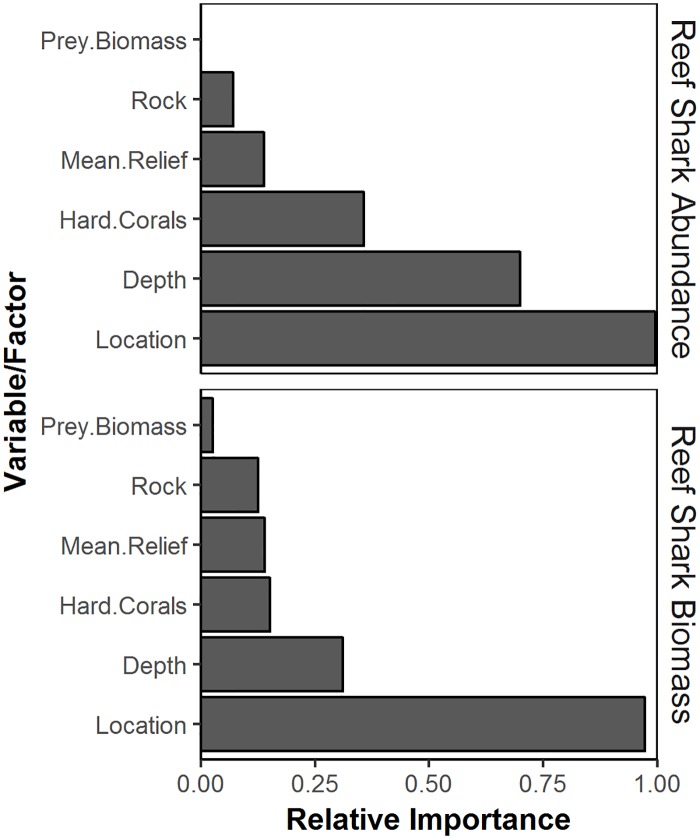
Importance scores for each explanatory variable in predicting the abundance and biomass of reef sharks.